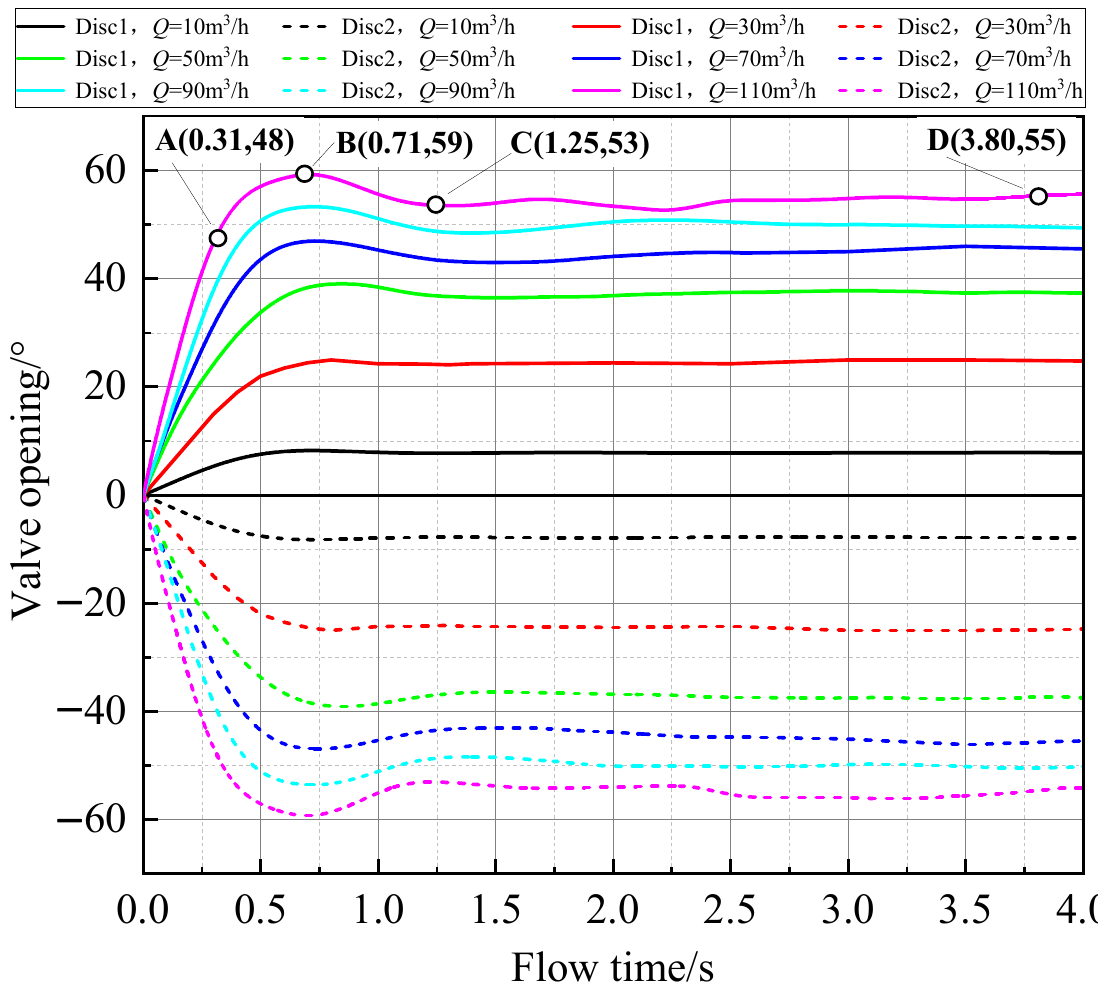
Figure 11. The transient opening curve of the dual disc check valve. 0A stage (opening the discs at a constant angular velocity): The valve opening increases linearly with time, and the slope of the curve remains the same, proving the disc’s angular velocity remains the